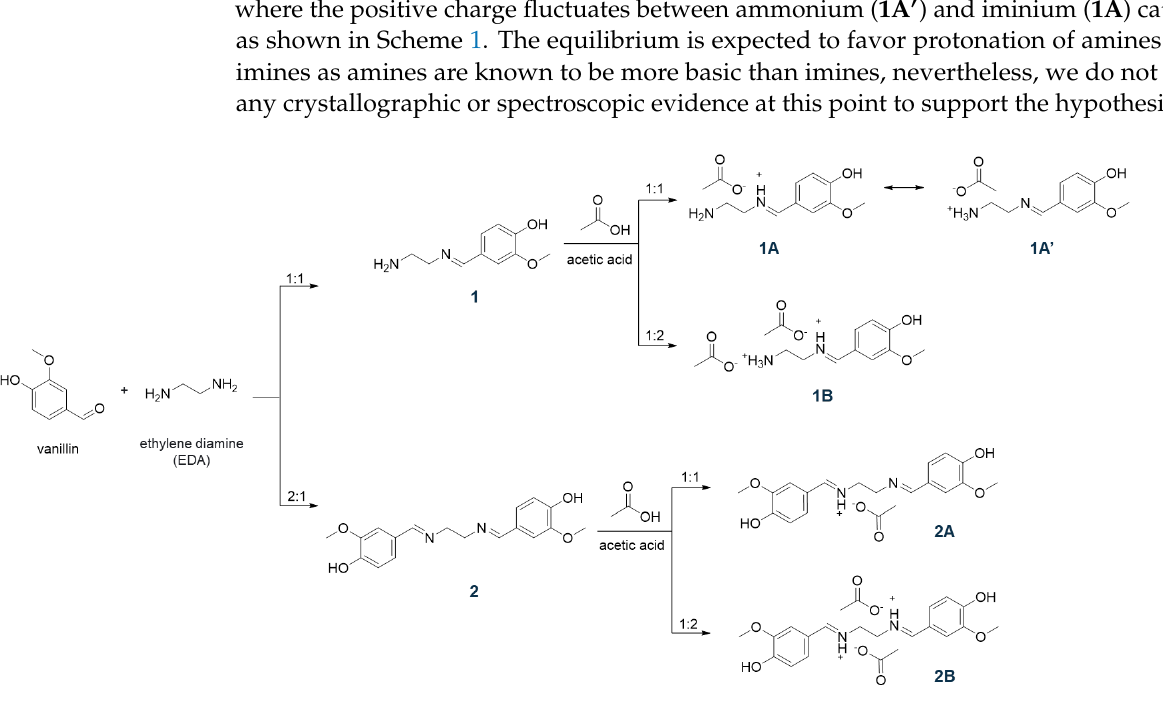
Scheme 1. Synthetic scheme of Schiff bases and related ILs.